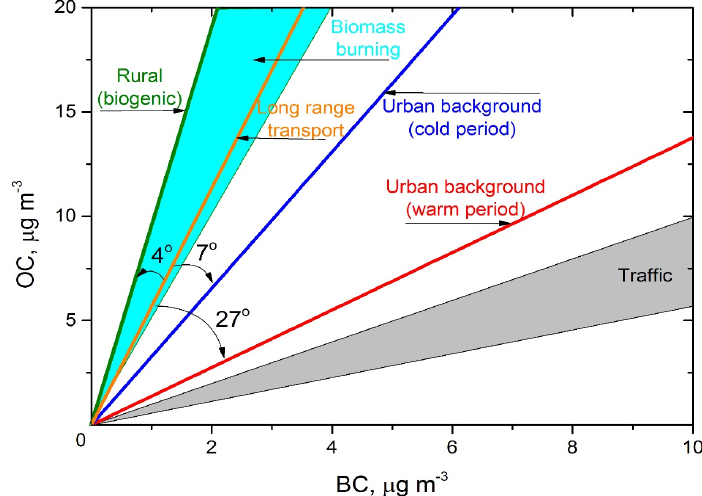
Figure 5. Alteration of parameter α value for different